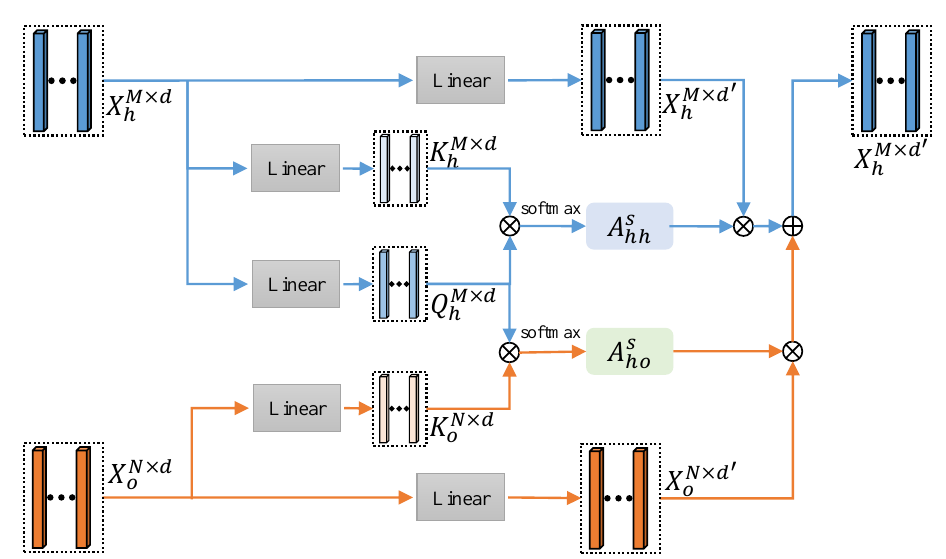
Figure 3. Implementation details of hand-centric attention mechanism and feature aggregation. General relation graph A g is not shown here for